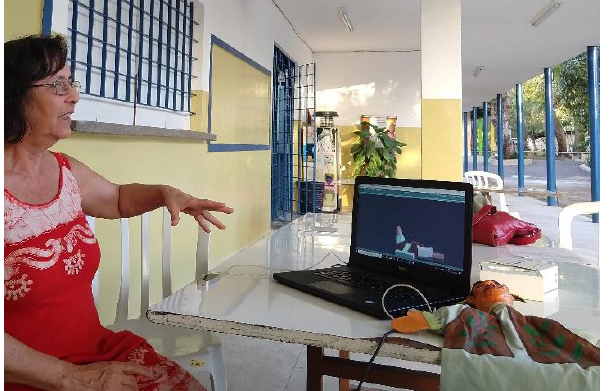
Figure 10. Maria Oliveira trying Virtual Puppet with not ideal light con- ditions for Leap Motion